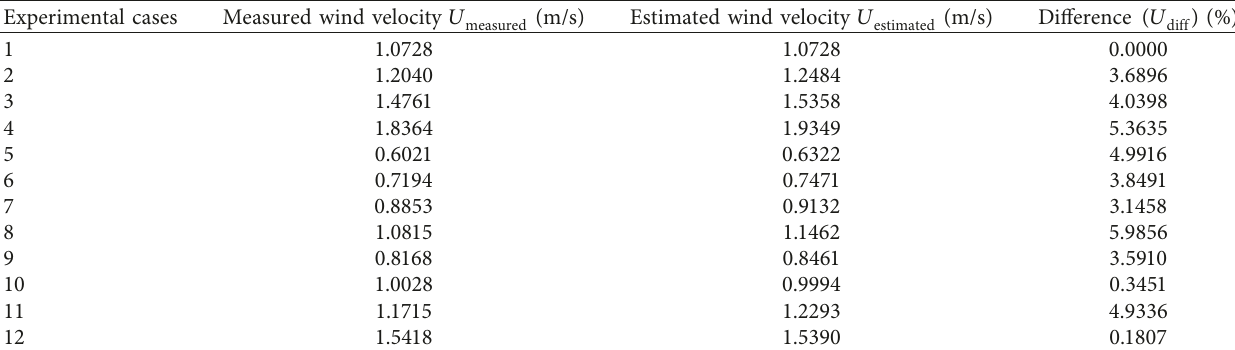
Table 5: Differences between measured wind velocity and estimated wind